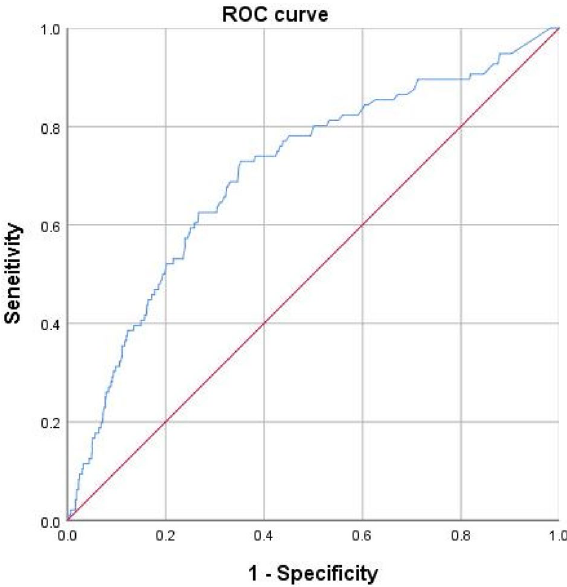
Figure 1. The optimal cut-off for d-dimer for predicting DVT was 1.08 µg/ml, determined by ROC when Youden index was maximum. The area under the curve for plasma d-dimer was 0.707 (95% CI, 0.651 to 0.762; p < 0.001), sensitivity: 72.9, specificity: